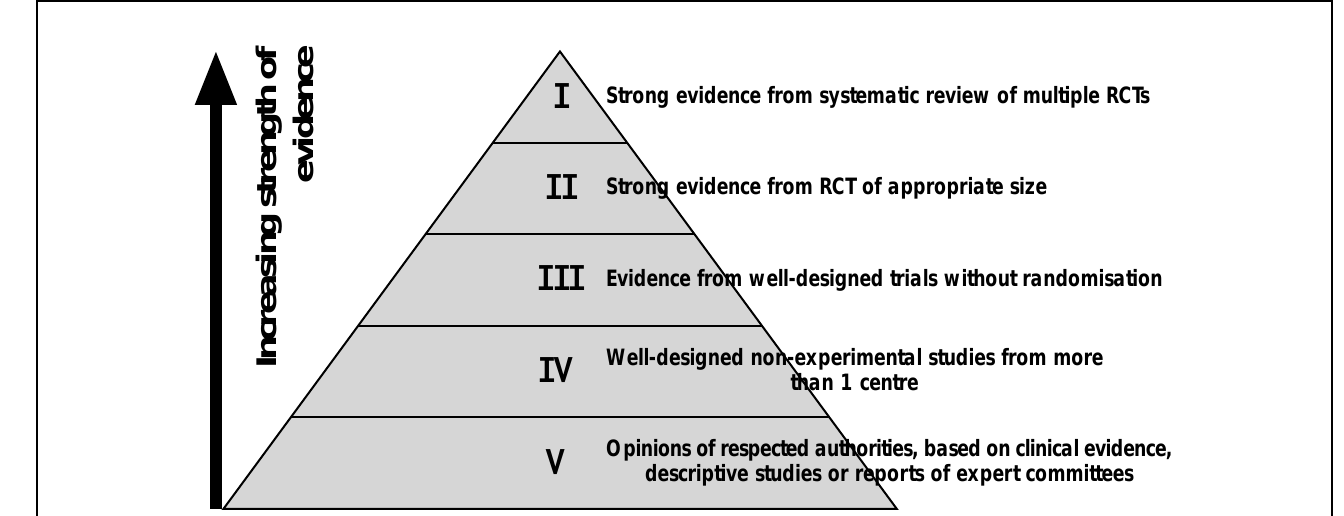
Figure 1: Hierarchy of evidence ranging from clinical experience up to systematic review of RCTs. A broad contribution from levels V - III is possible through outcomes research. (Modified from Moore and Petty